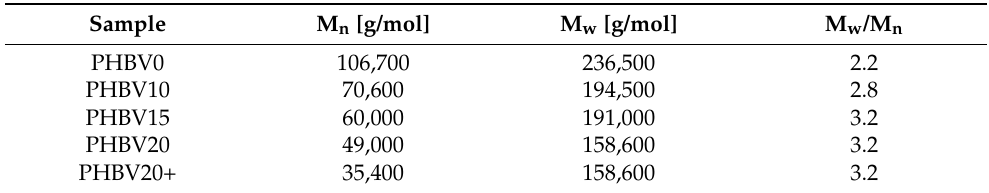
Table 2. Average molar masses (M n and M w ) and dispersity (M w /M n ) of the PHBV mats subjected to the reaction with LiBH 4 under different conditions.